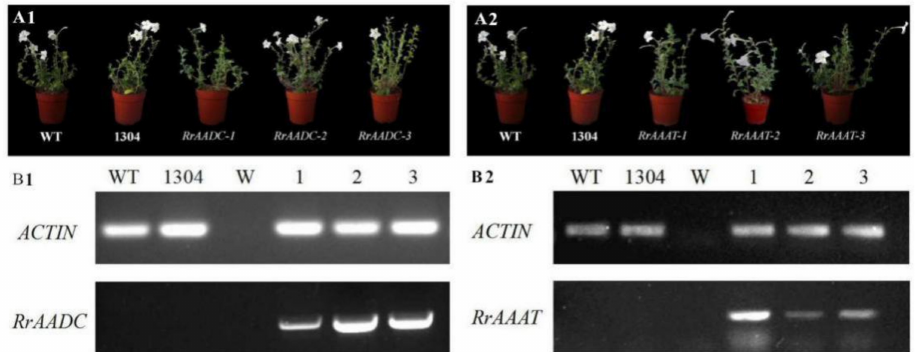
Figure 6. Phenotype and RT-PCR analysis of wild-type and RrAADC and RrAAAT transgenic Petunia